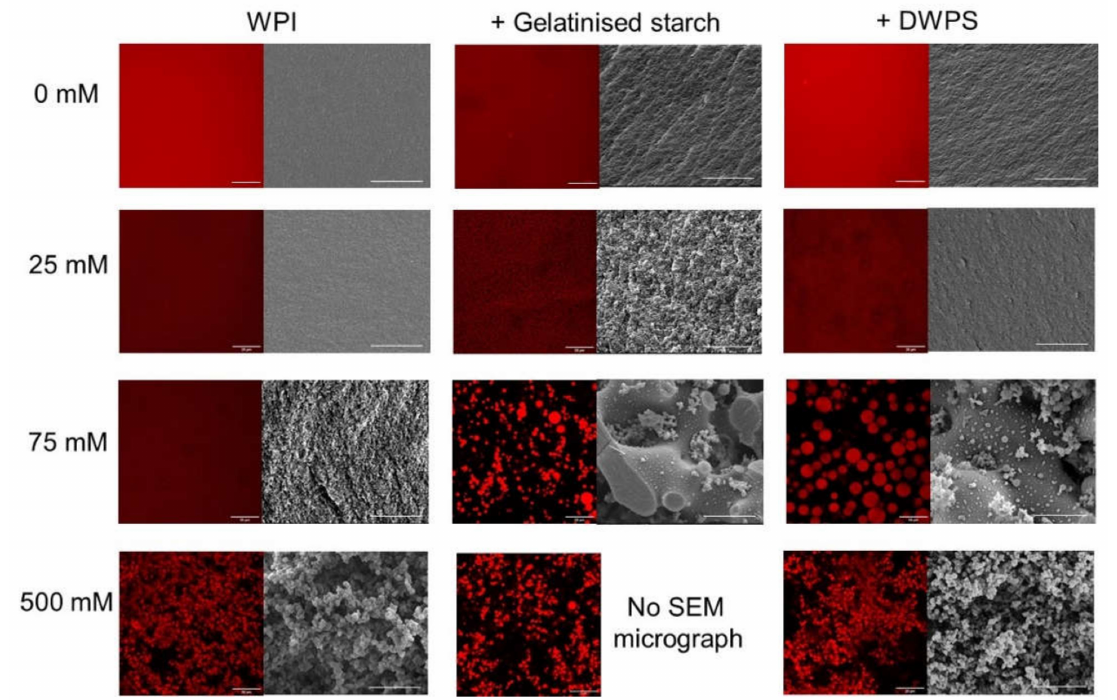
Figure 4. Effect of NaCl on the confocal scanning laser microscopy (CSLM) micrographs (630 × ) and scanning electron microscopy (SEM) micrographs (2500 × ) of 13% w / w WPI and 13% w / w WPI + 4% w / w gelatinised starch or DWPS gels at 0, 25, 75, and 500 mM NaCl. Note that SEM was not done on paste-like samples. The scale bars are 20 µ